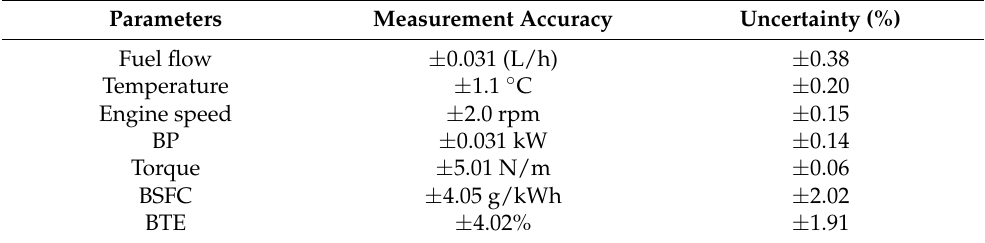
Table 4. Accuracy and uncertainty of the instruments used in the present